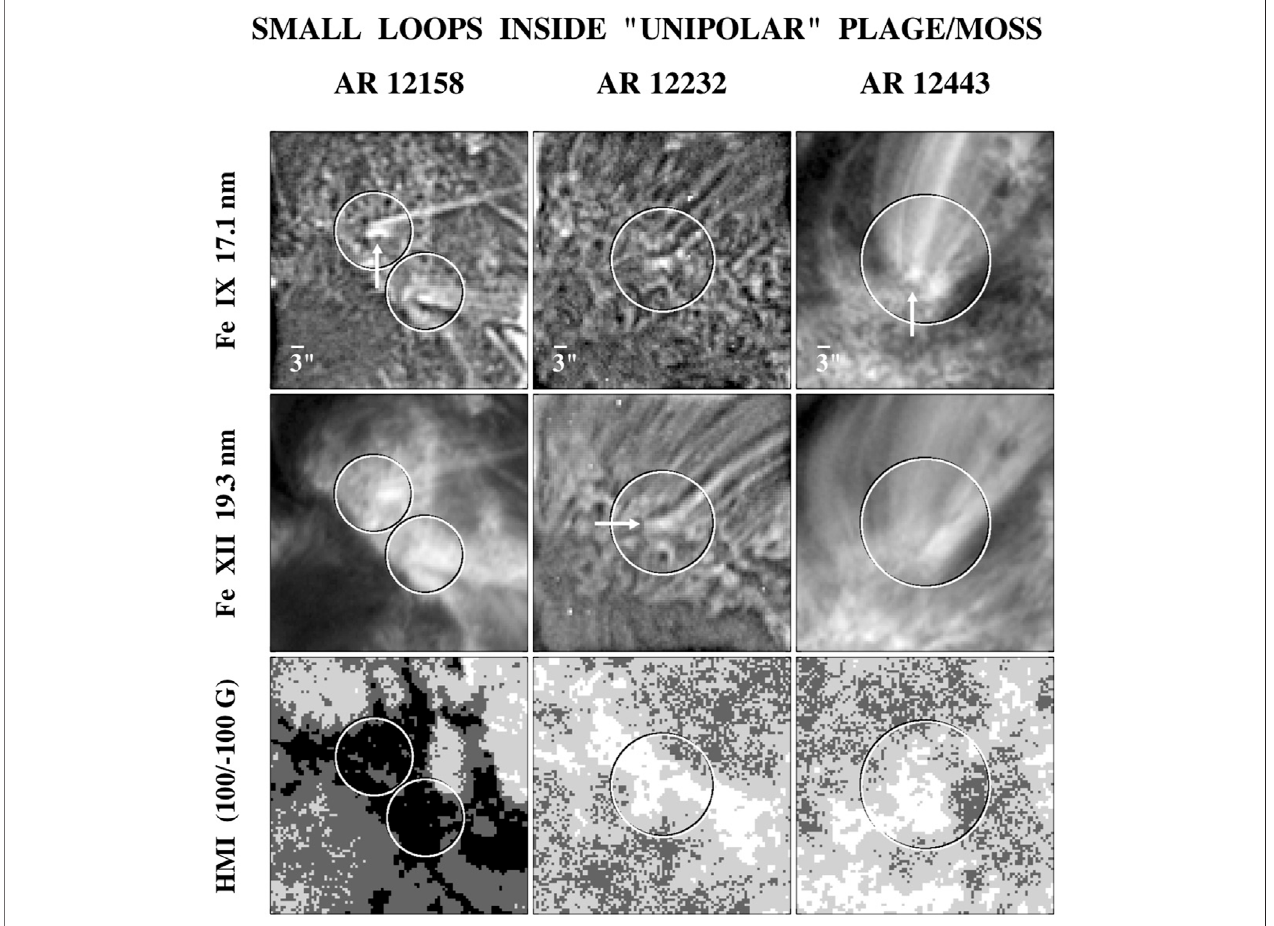
FIGURE 2 | Examples of small loops embedded in active region plages that are purely unipolar according to simultaneous magnetograms. The EUV images and magnetograms are from SDO. Gray scale for the magnetograms isas follows: white ( B los > 100 G);light gray (0 G < B los < 100 G); dark gray ( − 100 G < B los < 0 G); black ( B los < − 100 G).Theinverted-Ystructuresrepresentjet-likeout fl owsalonglongcoronalloopsthatarereconnectingwiththeunderlyingsmall-scaleloops.Ourhypothesis is that the reticulated EUV “ moss ” covering the plage areas consists mainly of small loops that continually reconnect with the active region loops and are the main source of the coronal heating in active